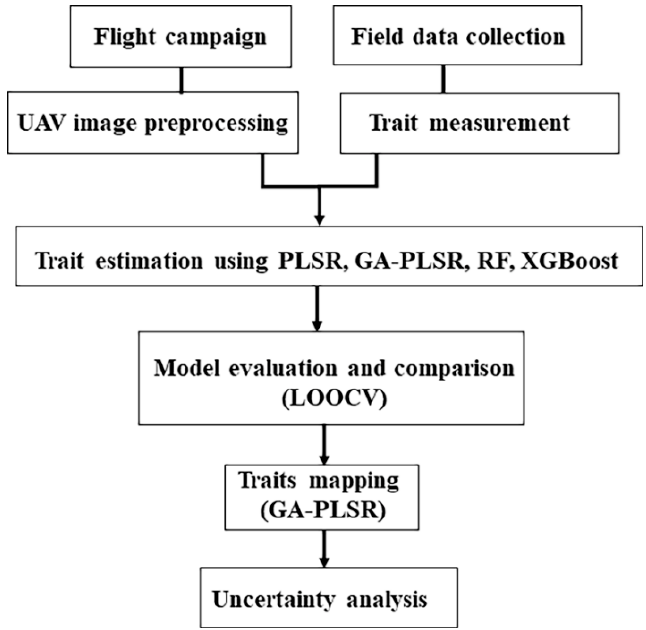
Figure 3. Overview of the study workflow.